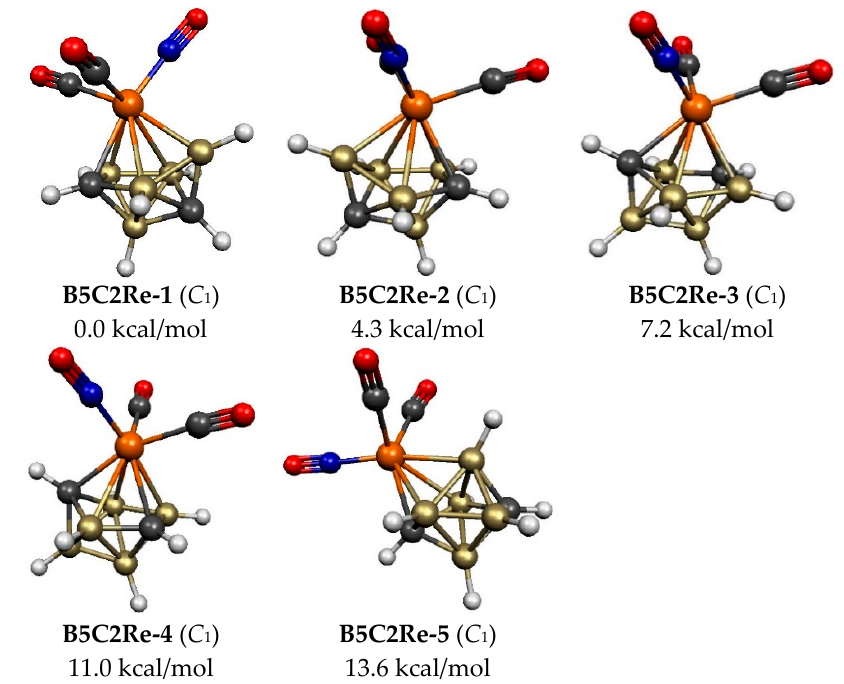
Figure 3. The five optimized lowest energy 8-vertex C 2 B 5 H 7 Re(CO) 2 (NO) structures. Table 1. The five optimized 8-vertex C 2 B 5 H 7 Re(CO) 2 (NO) structures within 26 kcal / mol of the lowest energy structure. Vertex